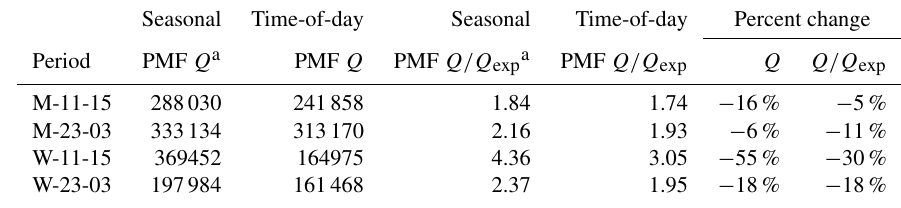
Table 4. Comparison of average Q and Q/Q exp in time-of-day PMF and seasonal PMF. Seasonal Time-of-day Seasonal Time-of-day Percent change Period PMF Q a PMF Q PMF Q/Q expa PMF Q/Q exp Q Q/Q exp M-11-15 288030 241858 1.84 1.74 − 16% − 5% M-23-03 333134 313170 2.16 1.93 − 6% − 11% W-11-15 369452 164975 4.36 3.05 − 55% − 30% W-23-03 197984 161468 2.37 1.95 − 18% − 18%